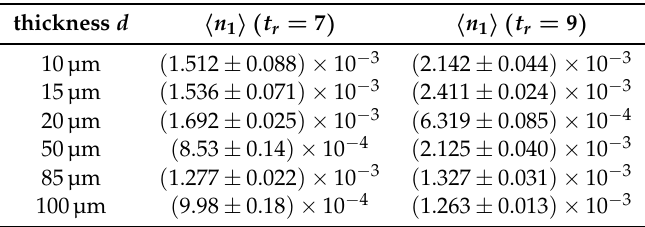
Figure 4. Angular dependence of the diffraction efficiency η ( θ ex ) . θ ex denotes the external angle of incidence of the beam with respect to the sample’s surface normal and corresponds to the rotation of the sample in the experimental setup. Symbols indicate measured data, while solid lines show the corresponding fits. The readout-laser wavelength was λ = 543nm. Both gratings had a lattice constant of Λ = 480nm and a thickness of d ≈ 100µm. ( a ) t r = 7s, n 1 ( 0 ) = ( 2.72 ± 0.21 ) × 10 − 3 , d = 101.5µm ± 1.0µm, L = 40.92µm ± 0.48µm. ( b ) t r = 9s, n 1 ( 0 ) = ( 2.77 ± 0.17 ) × 10 − 3 , d = 98.10µm ± 0.46µm, L = 53.21µm ± 0.58µm. Table 2. Average light refractive index modulation (cid:104) n 1 ( z ) (cid:105)